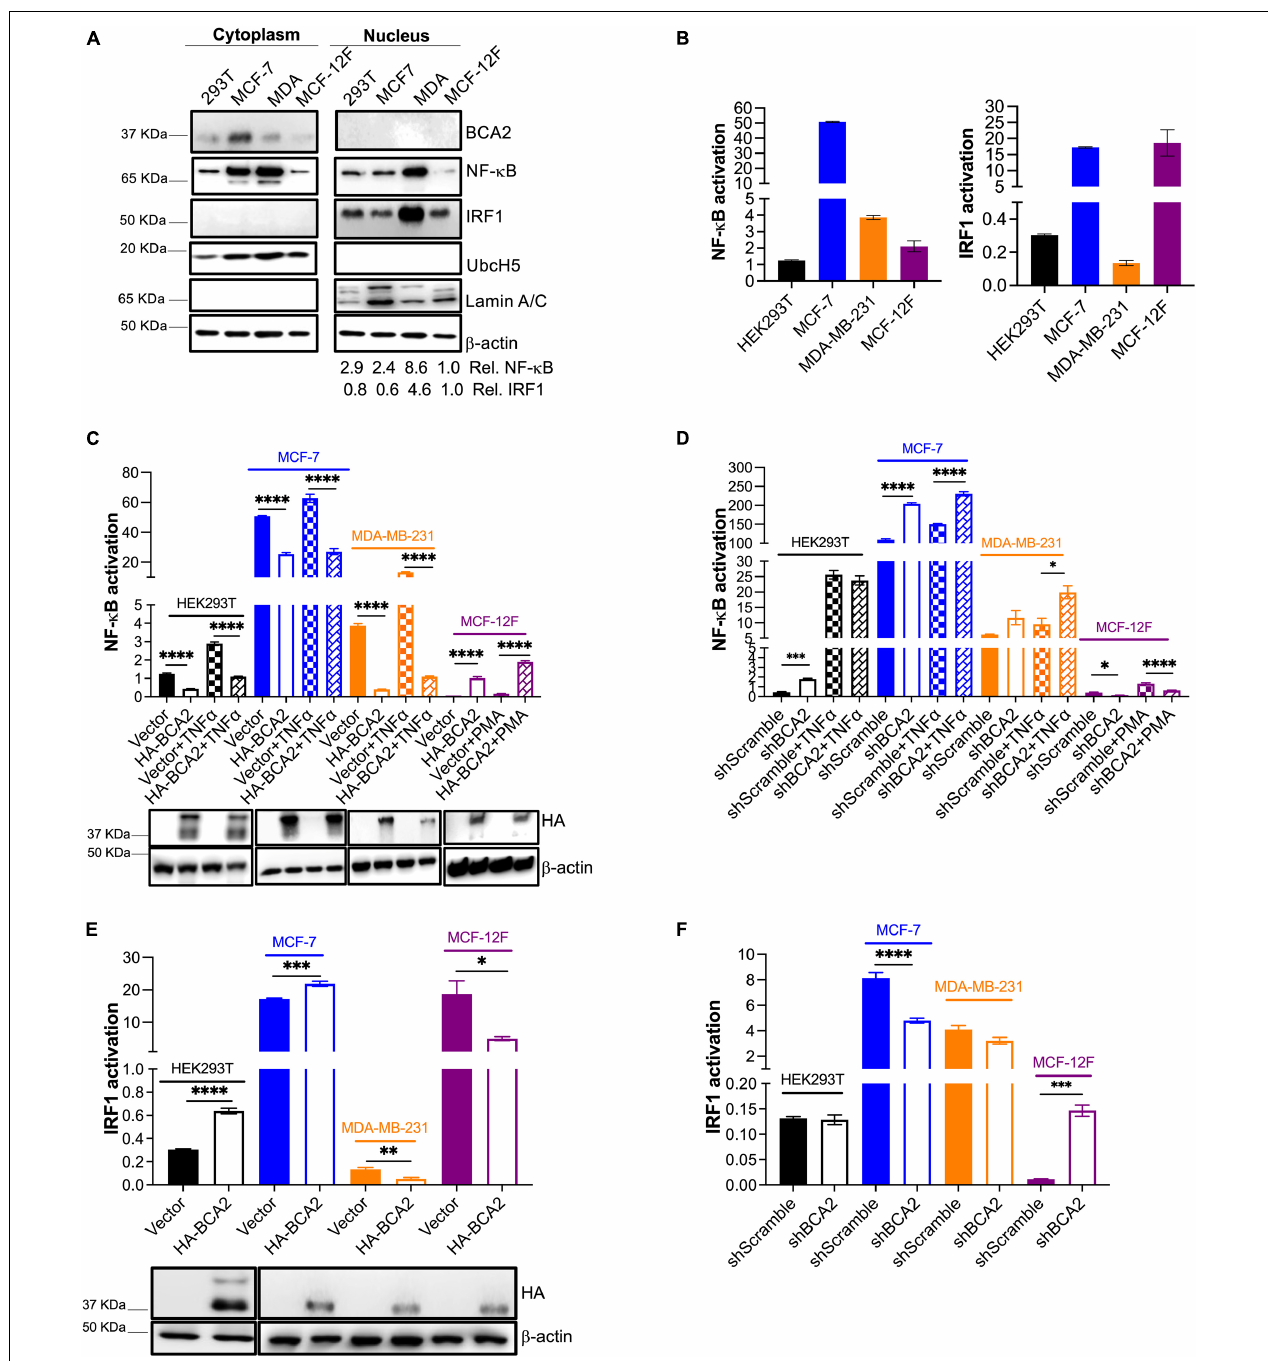
FIGURE 5 | BCA2 preserves its ability to regulate NF- κ B, but displays distinct roles in the regulation of IRF1 depending on the cellular context. (A,B) The endogenous levels of NF- κ B and IRF1 activation for HEK293T cells, MCF-7, MDA-MB-231, and MCF-12F were investigated by subcellular fractionation (A) and using luciferase reporter assays for each of these transcription factors (B) . (C) The effects of overexpressing HA-BCA2 on NF- κ B activation were measured by luciferase reporter assays on HEK293T cells, MCF-7, MDA-MB-231, and MCF-12F. Expression of HA-BCA2 was verified by western blot (bottom panels). (D) Complementary assays were performed by depleting the endogenous levels of BCA2. BCA2 depletion was verified on the day of analysis by RT-qPCR (not shown). (E) The effects of overexpressing HA-BCA2 on IRF1 activation were measured by luciferase reporter assays on HEK293T, MCF-7, MDA-MB-231, and MCF-12F cells. Expression of HA-BCA2 was verified by western blot (bottom panels). (F) Complementary assays were performed by depleting the endogenous levels of BCA2. BCA2 depletion was verified on the day of analysis by RT-qPCR (not shown). * p < 0.05, ** p < 0.01, *** p < 0.001, **** p < 0.0001. Data correspond to the mean and SEM of 3 independent